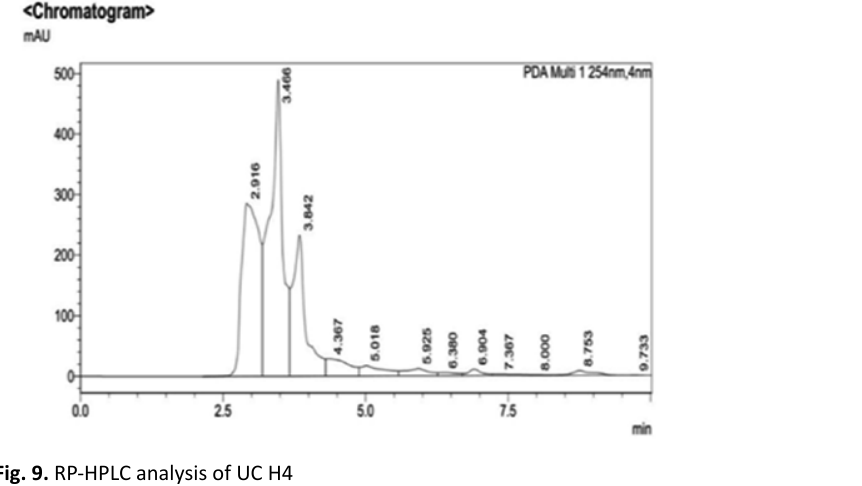
Fig. 9. RP-HPLC analysis of UC H4